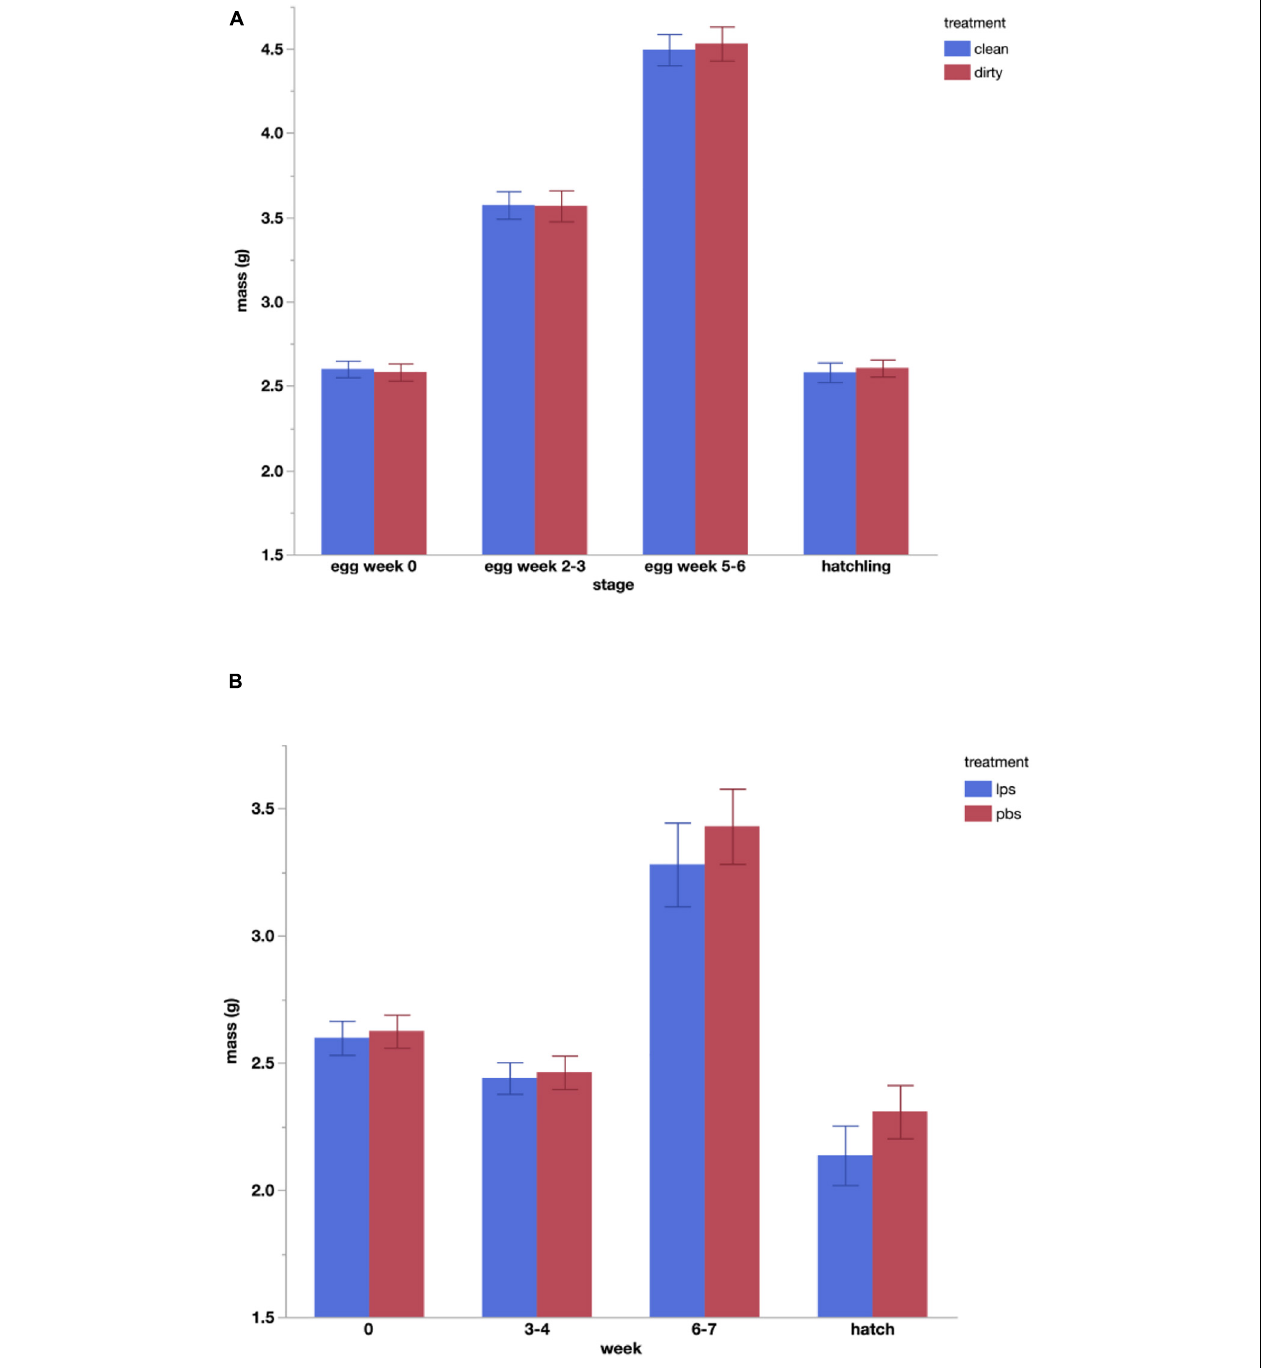
FIGURE 2 | Changes in mean ( ± standard error) mass of eggs over the course of incubation and resultant hatchling mass of keelback snakes ( Tropidonophis mairii ) for the two experiments. (A) Eggs incubated on untreated soil from a natural nest site (Dirty) vs. soil from the same site that had been autoclaved (Clean). (B) Eggs injected with 30 µ L lipopolysaccharide solution after week 4 (LPS) vs. eggs injected with 30 µ L phosphate buffered saline (PBS) after week 4.